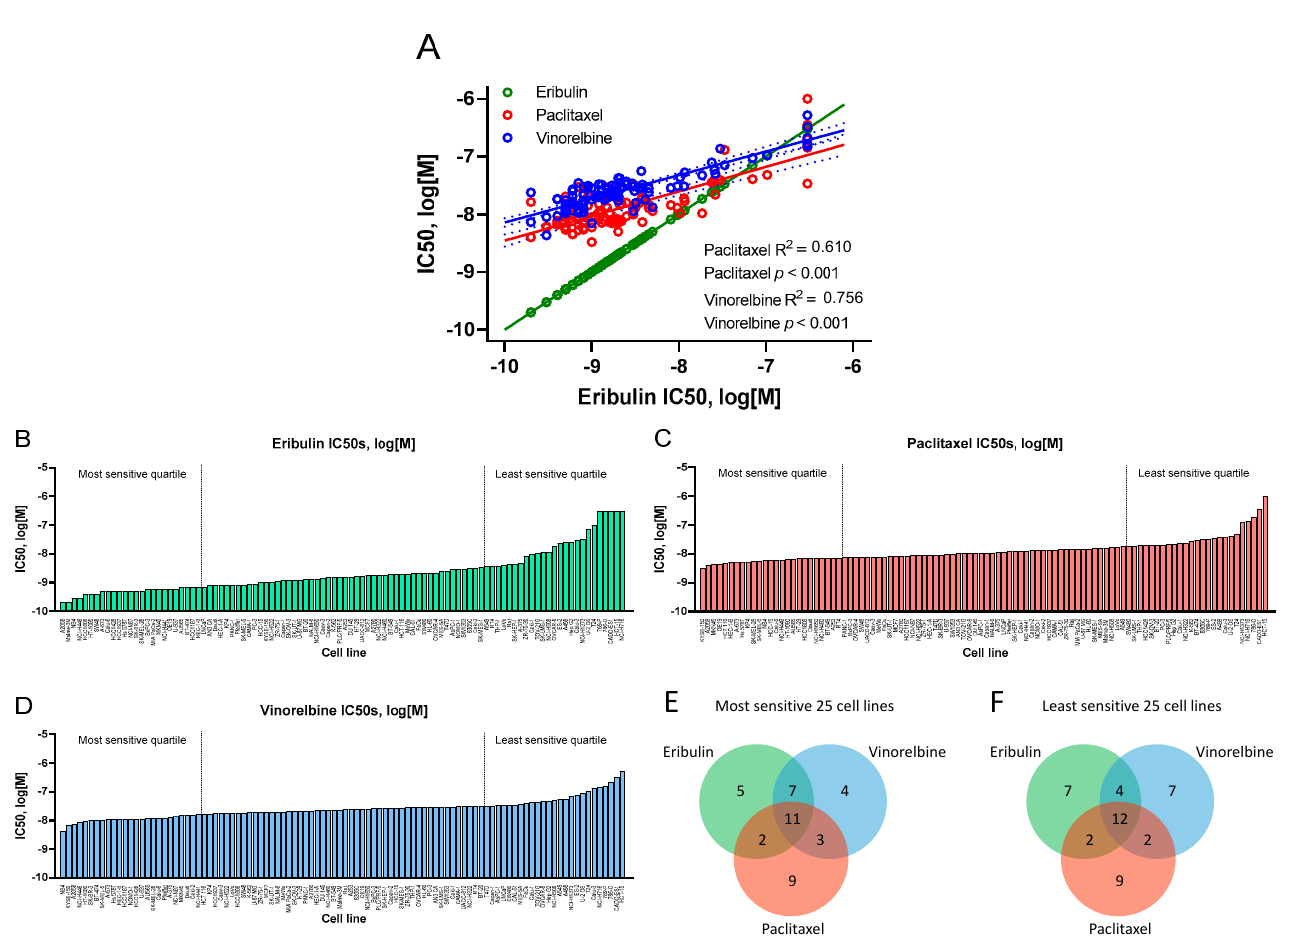
Figure 1. Antiproliferative effects of eribulin, paclitaxel and vinorelbine on 100 CCLE cell lines. ( A ) Correlations of IC50s for eribulin versus paclitaxel and vinorelbine, with eribulin versus itself shown to compare slopes with paclitaxel and vinorelbine (R 2 and p -values not shown for eribulin versus itself). For eribulin ( B ), paclitaxel ( C ) and vinorelbine ( D ), cell lines are ordered from most sensitive (left) to least sensitive (right), with IC50s as log[M]. The most and least sensitive quartiles for each drug are delineated by vertical dashed lines. Measured IC50s for 5 eribulin and 1 paclitaxel cell lines exceeded the highest concentrations tested for these 2 drugs; see Material and Methods for correction strategies used. Panels ( E , F ) show Venn diagrams of numbers of unique and overlapping cell lines in the most and least sensitive cell line quartiles for each drug. Table 1. Antiproliferative activities (IC50s) against 100 CCLE cell lines 1